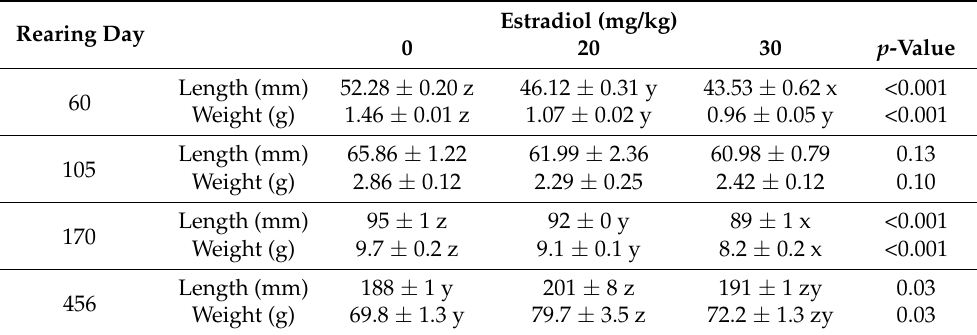
Table 2. Mean ( ± SE) fish length and weight for brown trout Salmo trutta fed three different concen- trations of estradiol/kg of feed for 60 days starting at initial feeding. Means with different letters in the same row differ significantly ( p < 0.05, n =